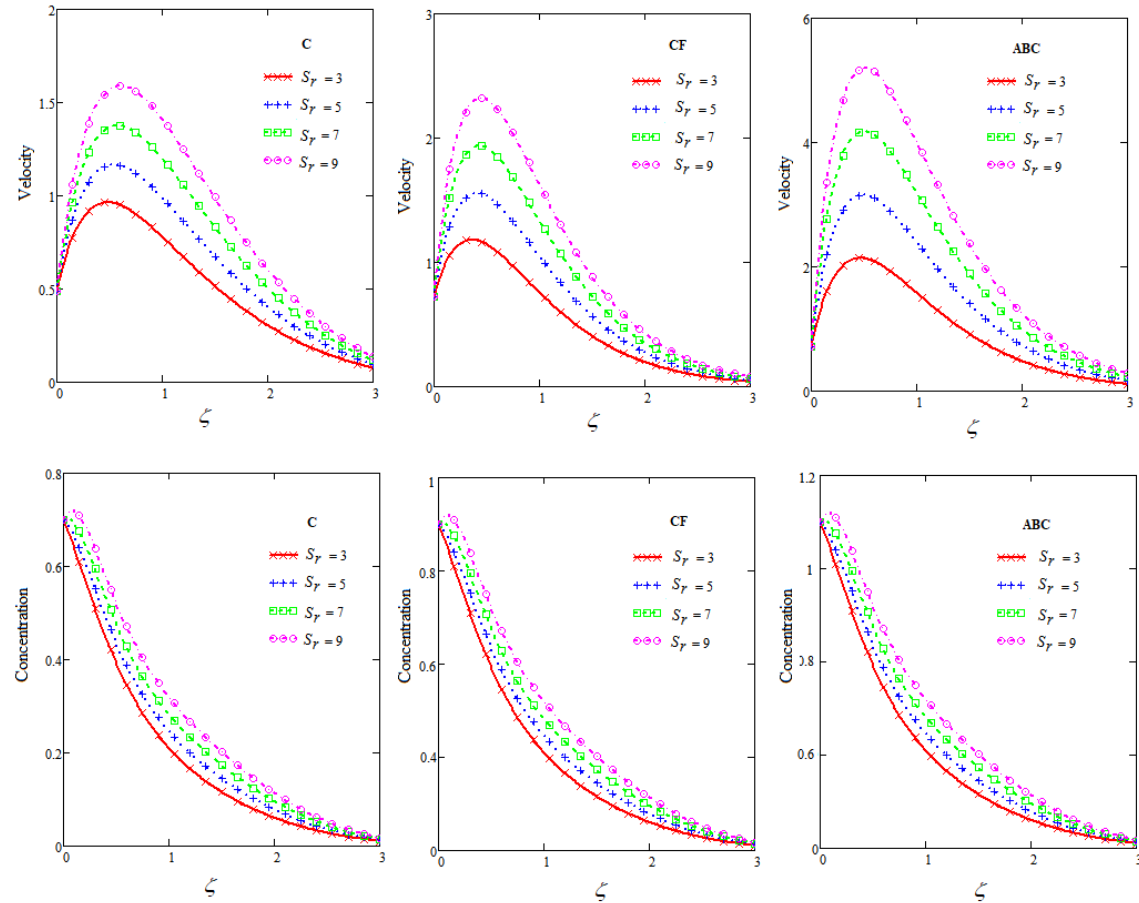
Figure 8. Velocity and concentration curves corresponding to C, CF and ABC with variable S r where P r = 7, S c = 0.66, κ = 0.5, G m = 5, H = 3, R = 5, G r = 10, K r = 2, M = 0.5, γ 1 = 0.1, h = 0.5, c = 1.05 and b =